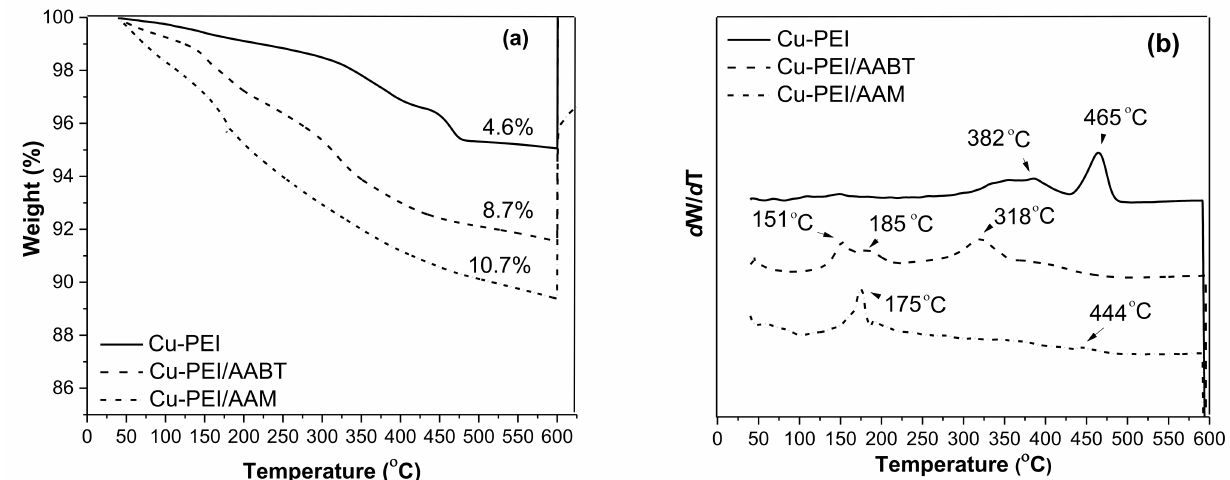
Figure 3. TGA thermograms of the Cu NPs with different ligands ( a ) and DTG curves of the Cu NPs with different ligands ( b ).